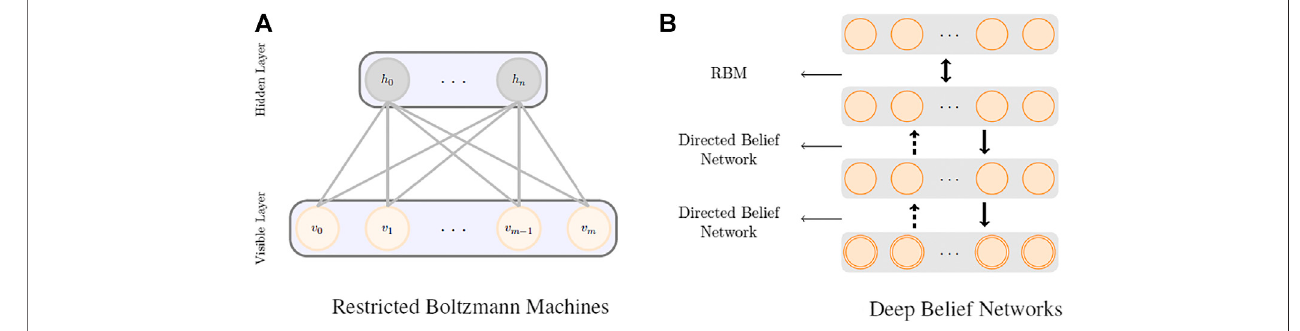
FIGURE 1 | RBM (A) and DBN (B) model